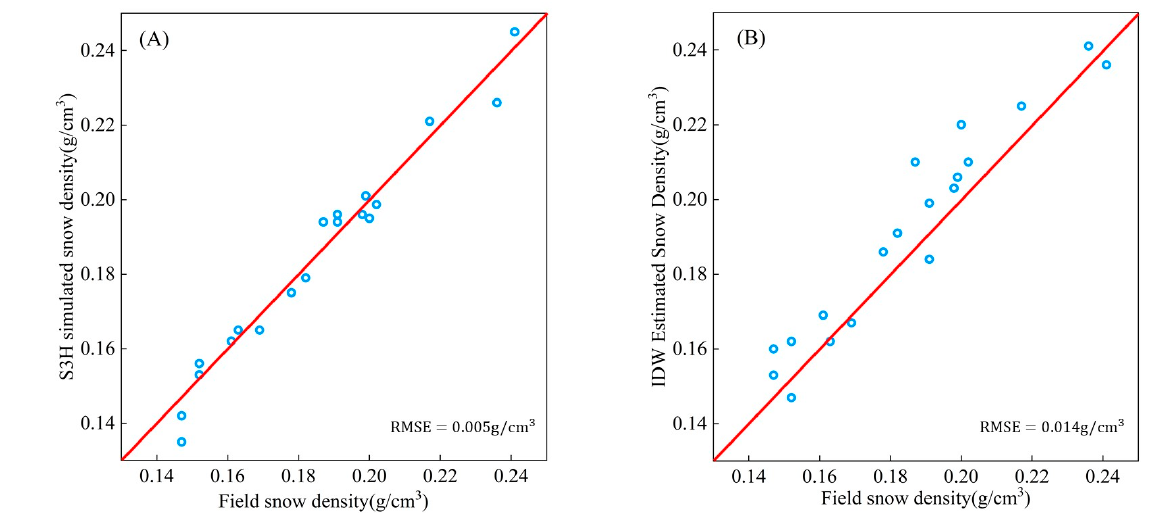
Figure 6. Distribution of validated sample values and inversion values for S3H decomposition ( A ) and IDW interpolation ( B ) of snow density.